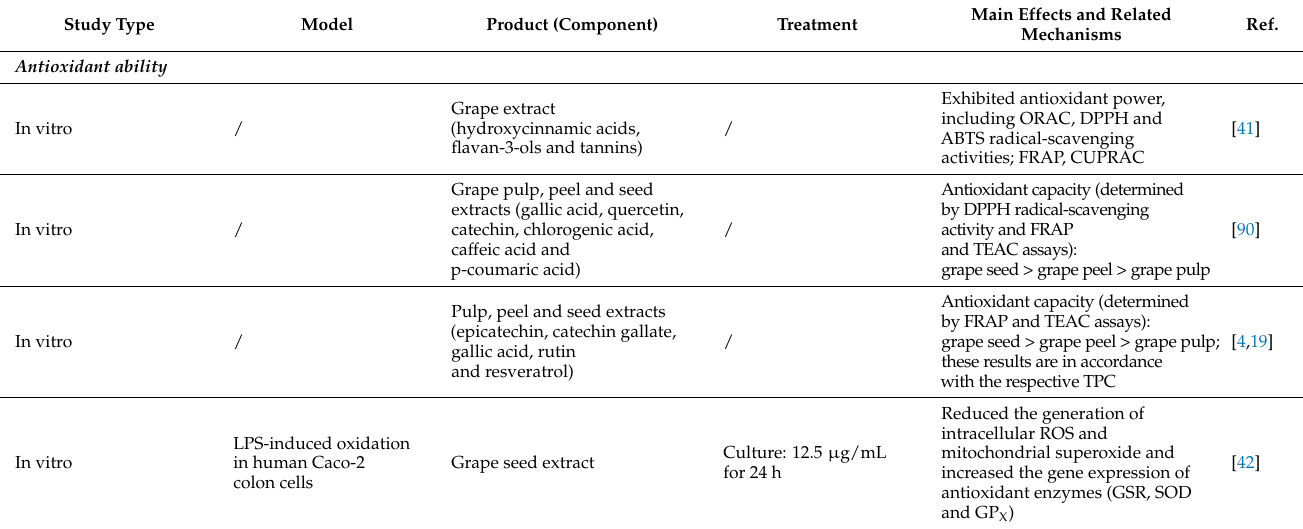
Table 2. Health benefits of